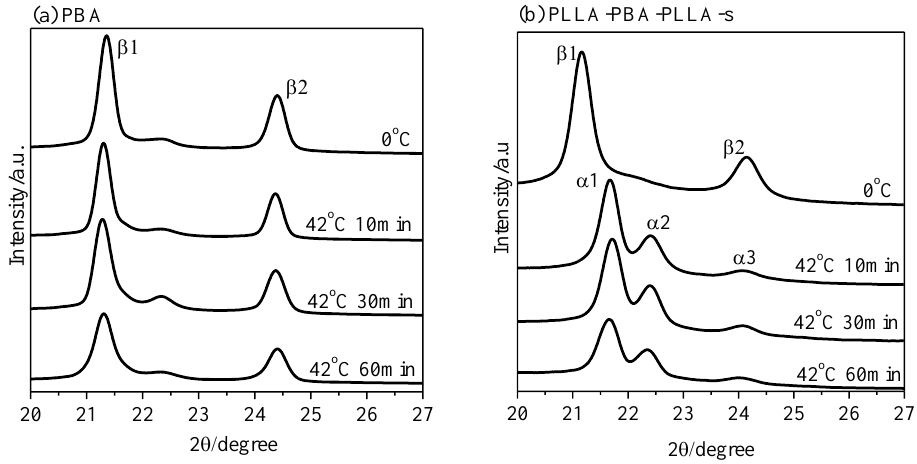
Figure 9. WAXD patterns of ( a ) PBA and ( b ) PLLA-PBA-PLLA-s after initial melt crystallization at 0 °C followed by annealing at 42 °C for different periods of time. (PLLA was held in its amorphous state).